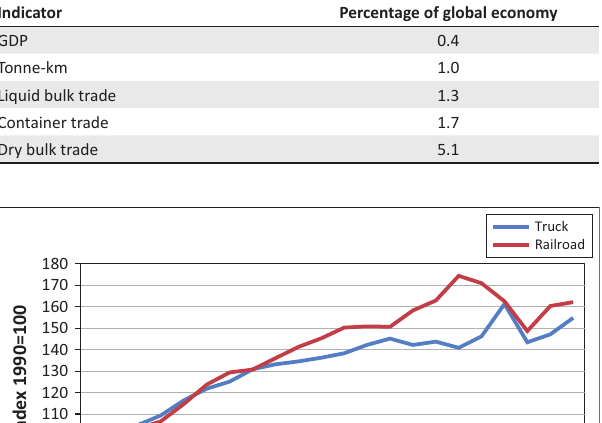
TABLE 1: Key transport and trade indicators – South Africa versus the global economy (Stellenbosch University, 2015). Indicator